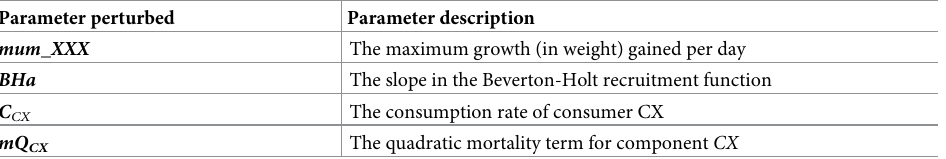
Table 2. Overview of the perturbed